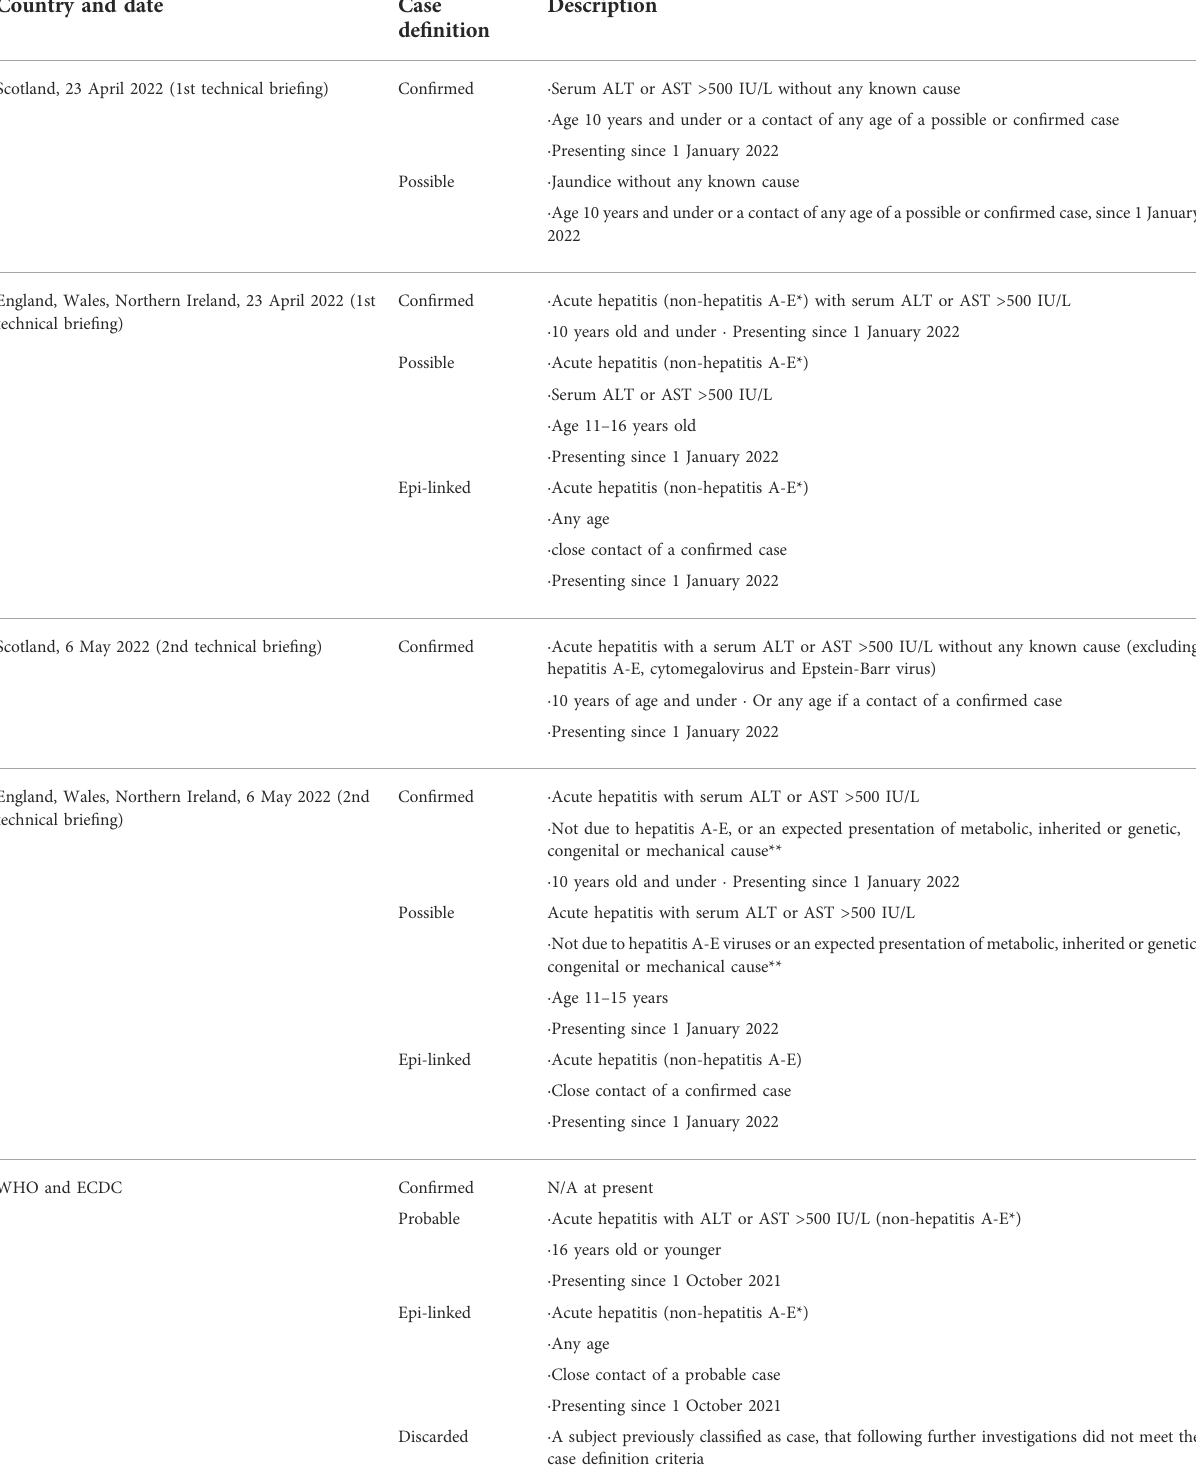
TABLE 1 Working case de fi nitions of AS-Hep-UA over time (WHO, 2022a; Baker et al., 2022). All de fi nitions refer to cases of unknown aetiology, thus excluding cases associated with speci fi c infections, drug toxicity, metabolic, hereditary, or autoimmune disorders. Country and